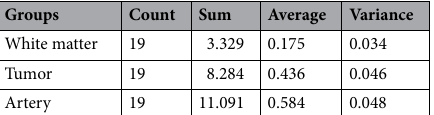
Table 2. Summary table of peak intensity values in the nineteen samples analyzed.